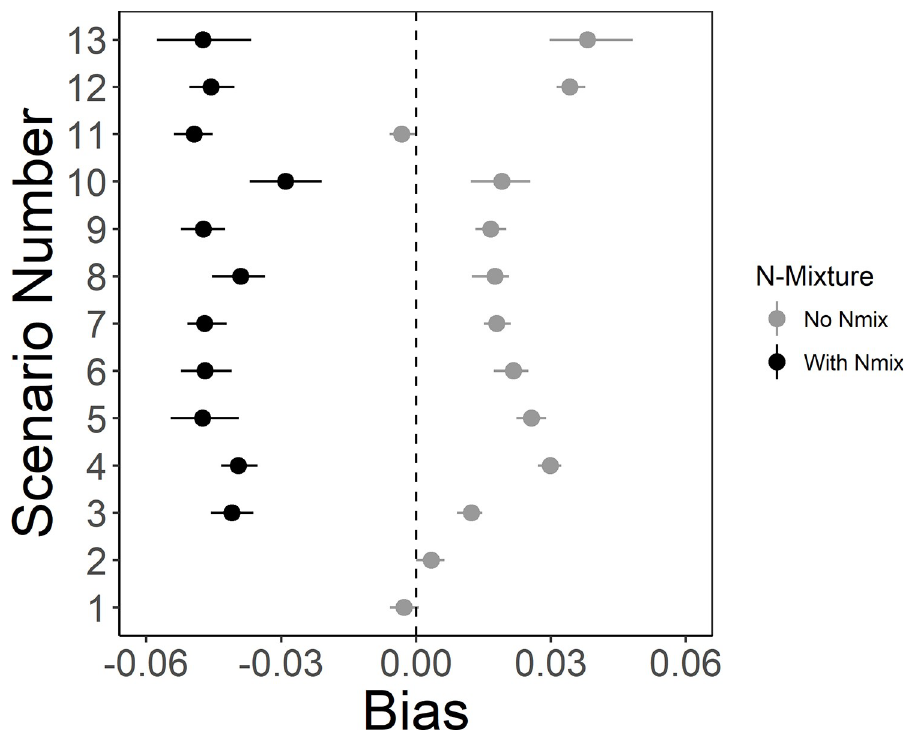
Fig 3. Bias of mean long-term population growth rates ( � λ ) from simulated lek counts of lesser prairie-chickens based on individual-based models (see Table 2). The bias between the mean estimated � l for each simulation and the true value for that simulation. Points represent the mean bias over all 100 simulations and whiskers represent the 95%